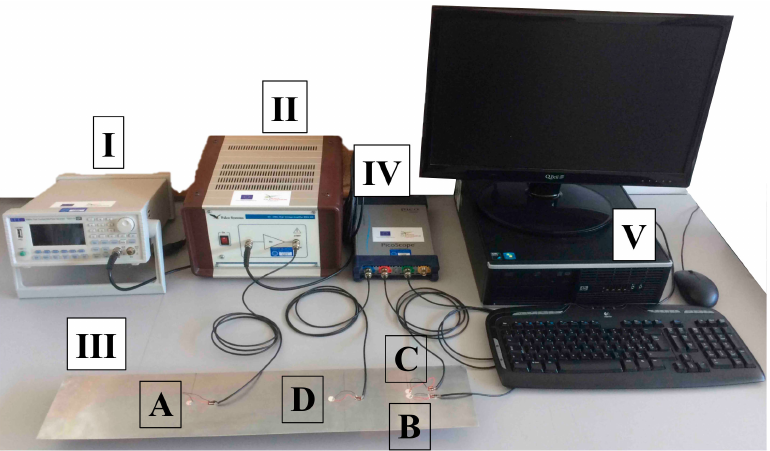
Figure 1. Experimental set-up.